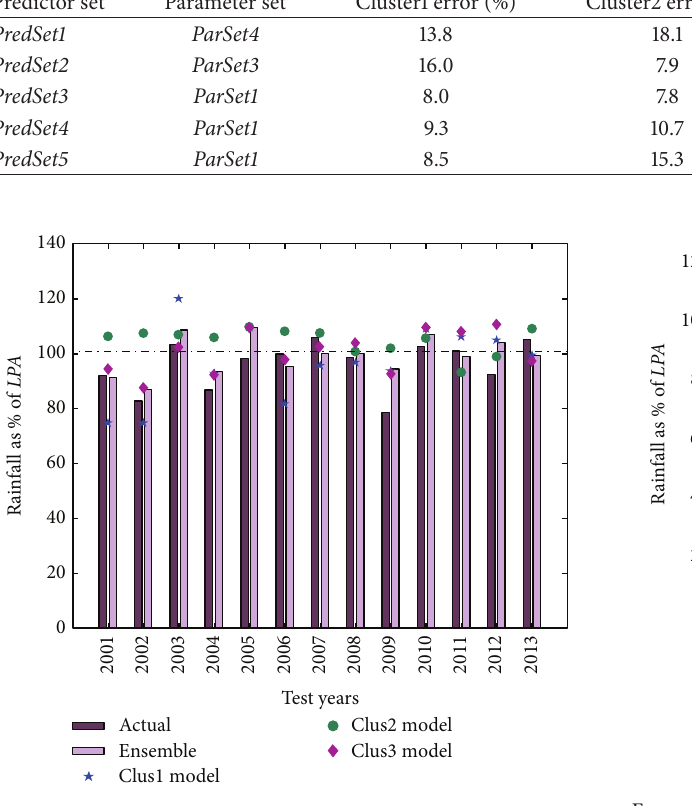
Figure 3: Performance of forecasts by proposed fuzzy clustering- based ensemble model and its respective three clusters models by MR for PredSet4 . The deep and light purple bars represent the actual and predicted ISMR in terms of percent of LPA . The symbols represent forecasts given by individual cluster models. The results are shown for test period 2001–2013.